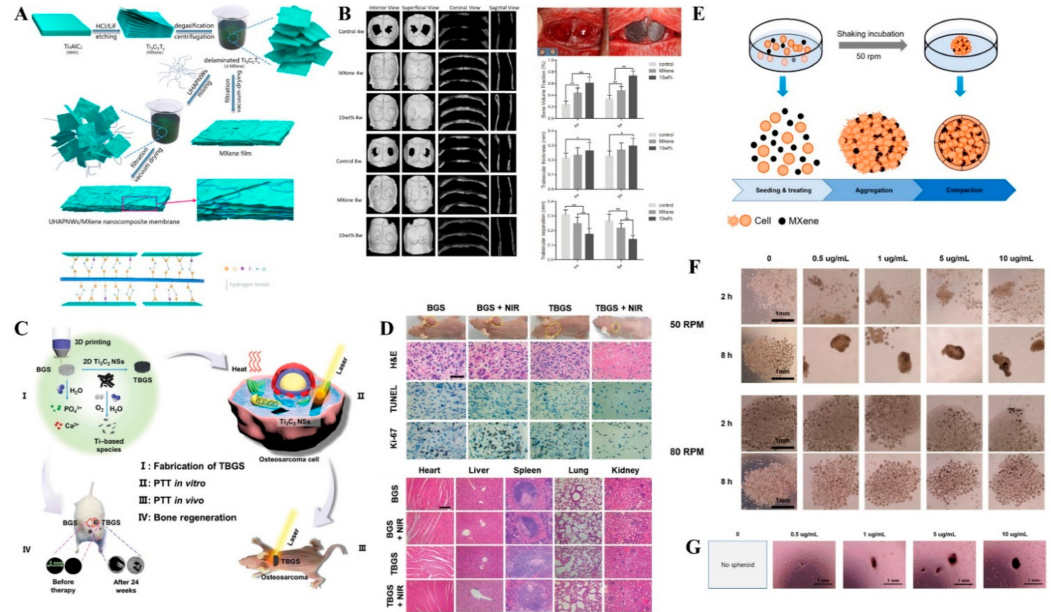
Figure 11. ( A ) Schematic illustration of the fabrication of hydroxyapatite nanowire/MXene (UHAP- NWs/MXene) composite membrane displaying hydrogen bonding interaction within the composite.